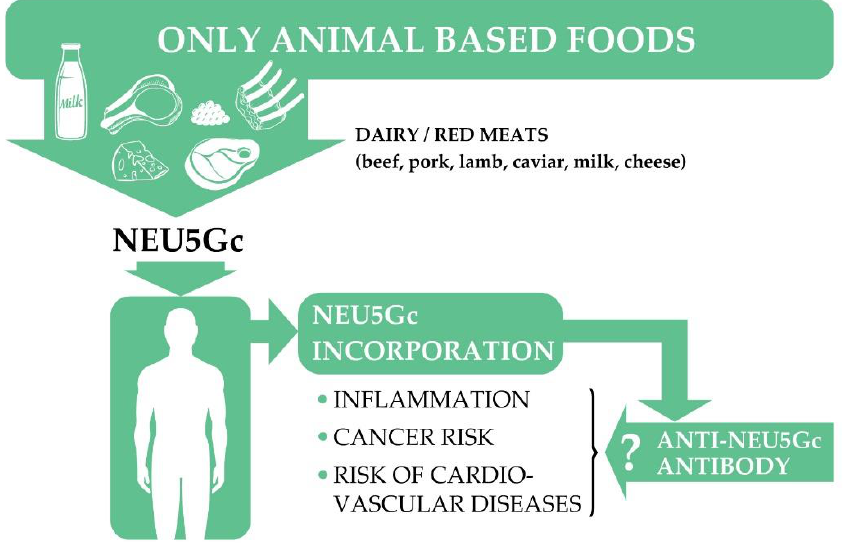
Figure 3. The potential role of animal food-derived Neu5Gc in the risk of certain diseases. Neu5Gc: N-glycolylneuraminic acid.